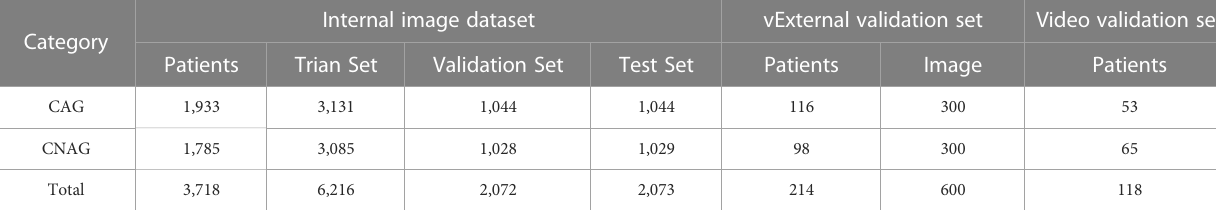
TABLE 1 Details of the three datasets.